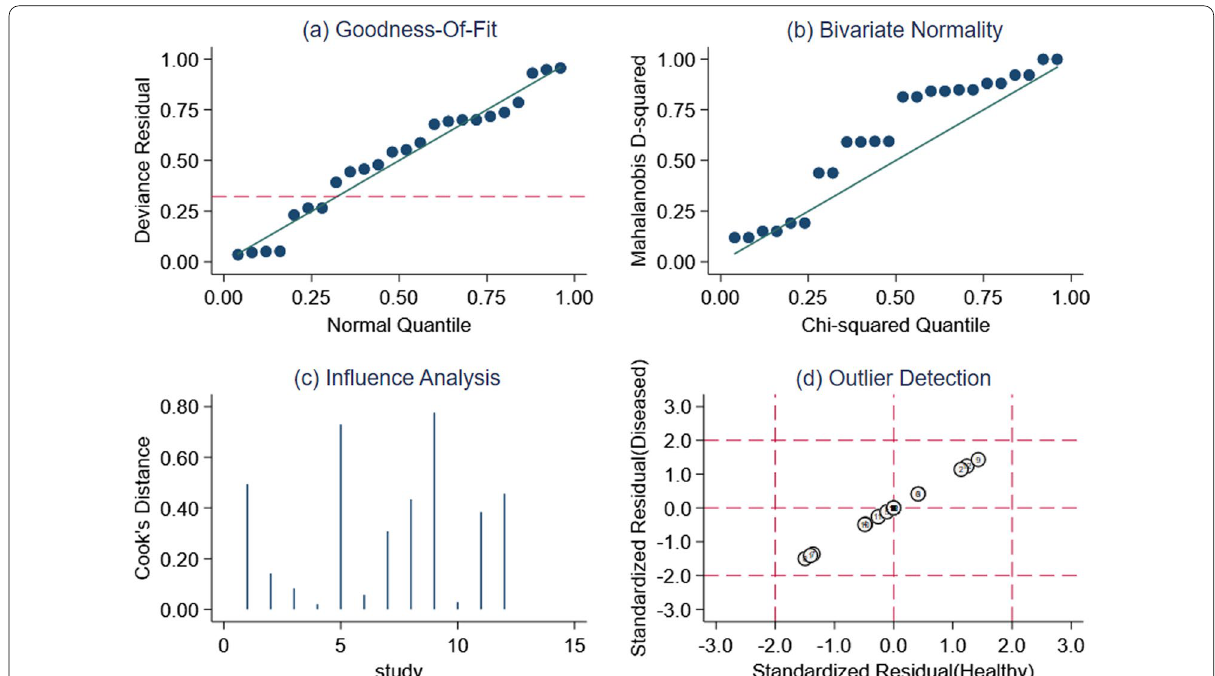
Fig. 5 Sensitivity analysis. a Goodness of fit; b bivariate normality; c influence analysis; and d outlier detection. All original articles had high stability and reliability and relatively high quality in the validation set